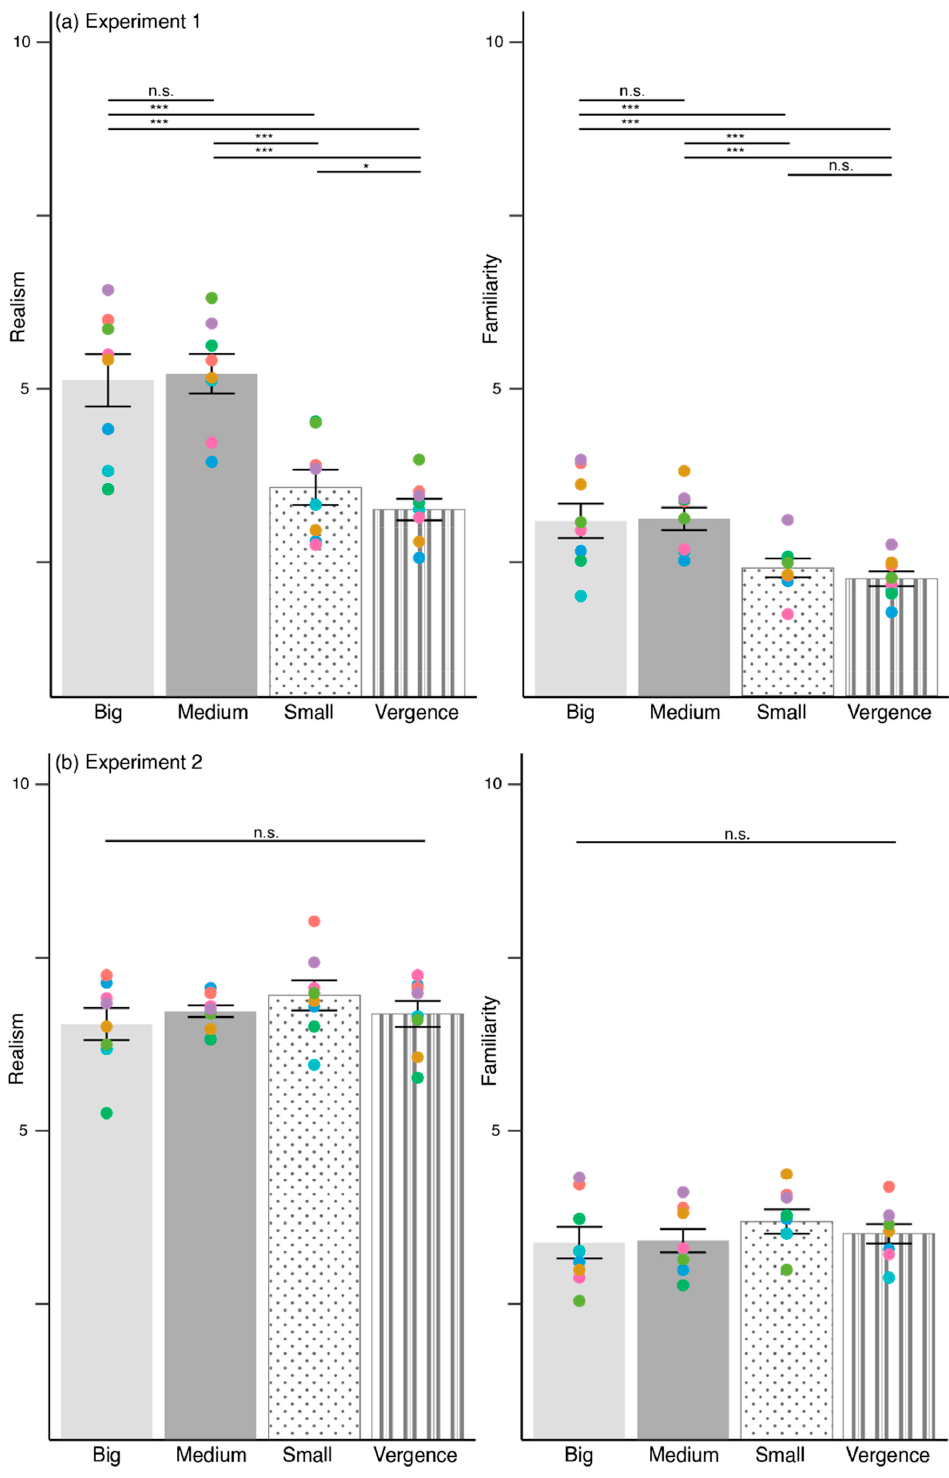
Figure 6. Realism and familiarity ratings in ( a ) Experiment 1, and ( b ) Experiment 2 across big, medium, small, and vergence pupils. The colored scatter corresponds to each eye model. Error bars depict standard error of means, S.E.M. *** p < 0.001, * p < 0.05, n.s.—non-significant.